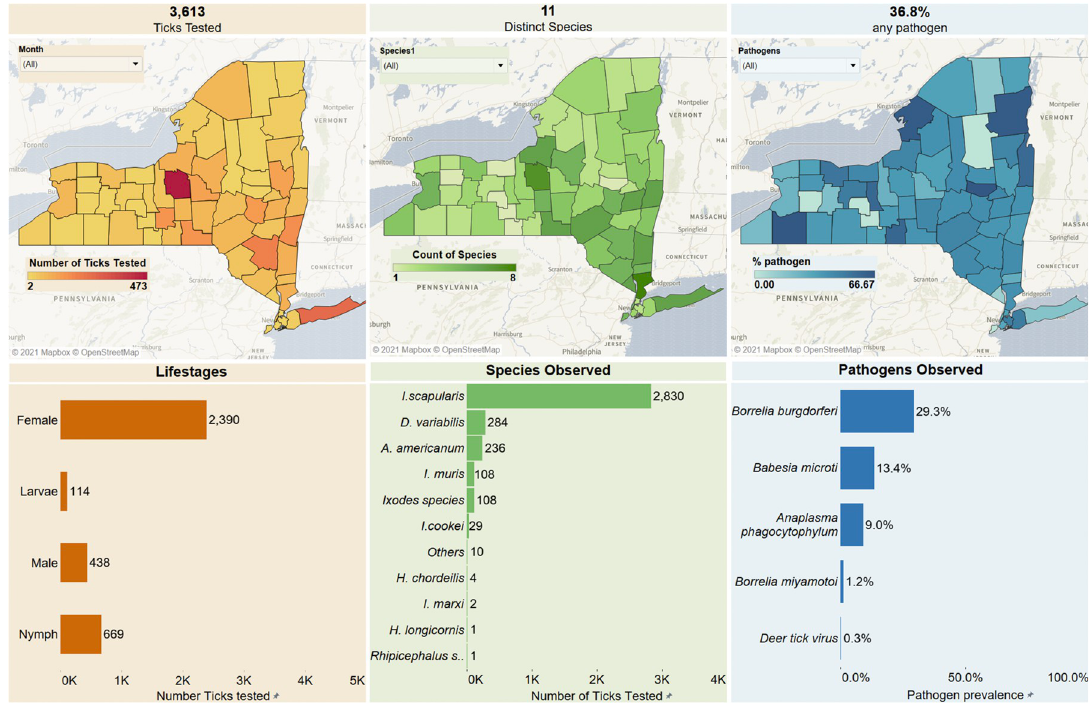
Fig 2. Example of the public-facing web application. The web-application automatically generates color-coded maps and bar graphs in real-time through a Tableau interface with the REDCap database containing tick information. This application displays tick life stages, species, and pathogen and can be filtered by location, time period, tick species, tick lifestage, or by pathogen. The base map for the images was obtained from Mapbox which is an open source map available at